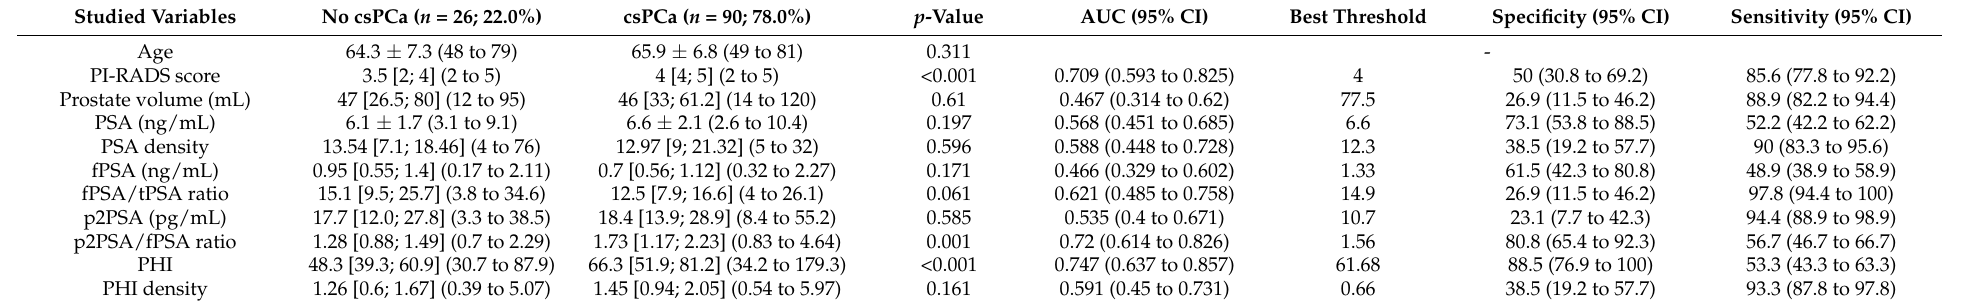
Table 3. Demographic and clinical characteristics of the study population stratified by presence of csPCa at RP. For each variable, the AUC of the corresponding ROC curve with the 95% confidence interval (CI) is shown. Best threshold for the identification of csPCa, according to the maximization of the Youden index, is reported with the accomplished sensitivity and specificity. Cases are defined as subjects with values equal to or greater than threshold, except for prostate volume where the opposite applies. Studied Variables No csPCa ( n = 26;